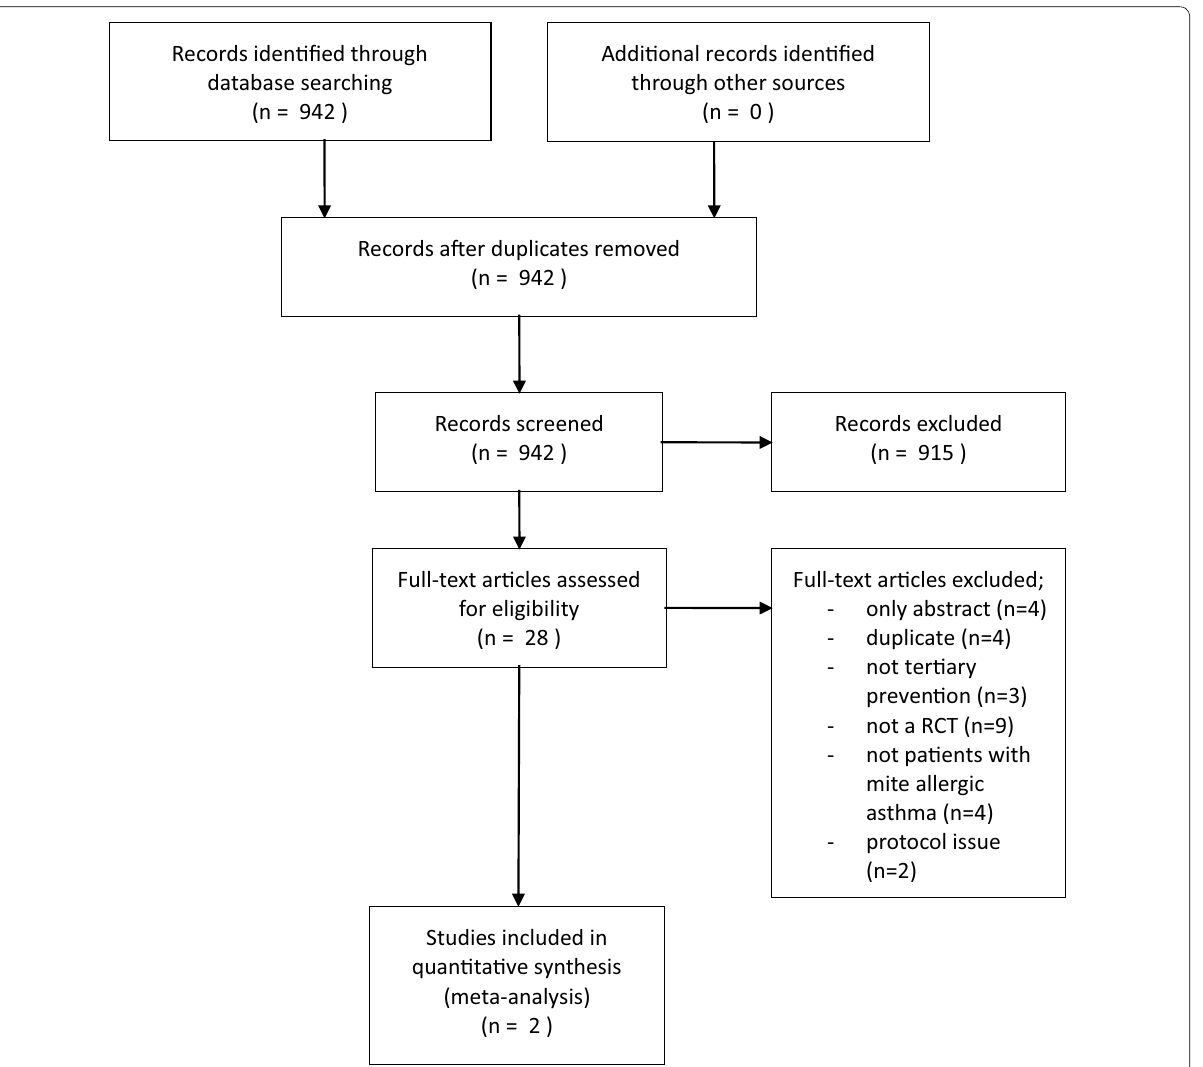
Fig. 1 Flow chart of the updating literature search and selection of